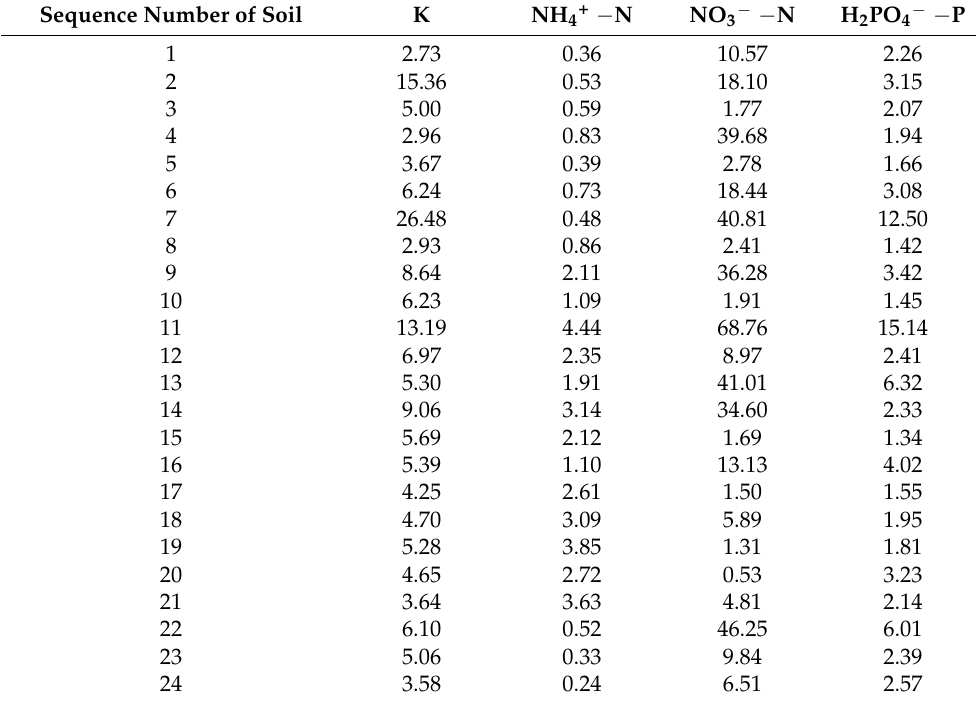
Table 2. Macronutrient contents of 24 lime concretion black soil samples (mg · kg − 1 ). Sequence Number of